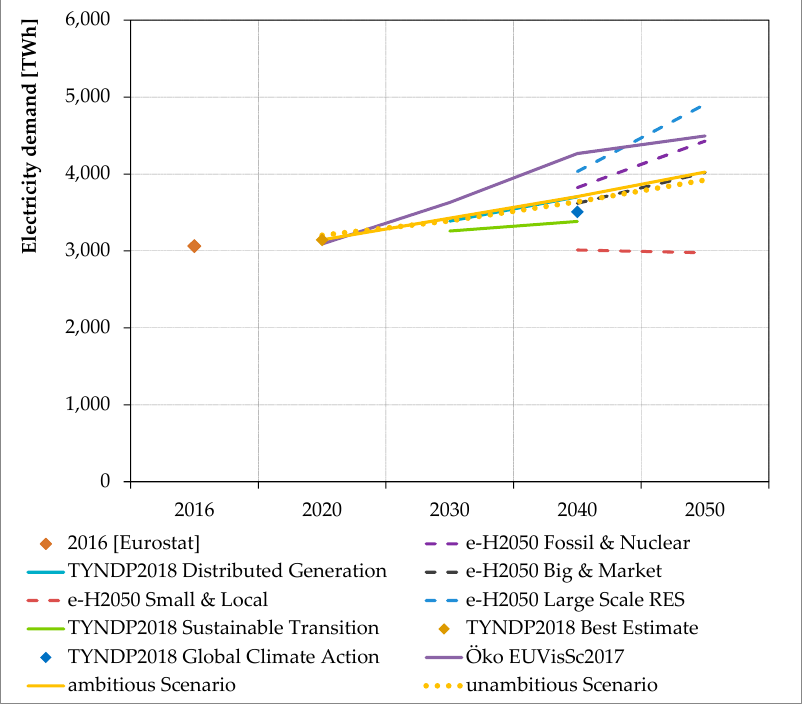
Figure 14. Annual electricity demand in EU28 countries. Sources: References [5,29–32]. Figure A2. Annual electricity demand in EU28 countries. Sources: References